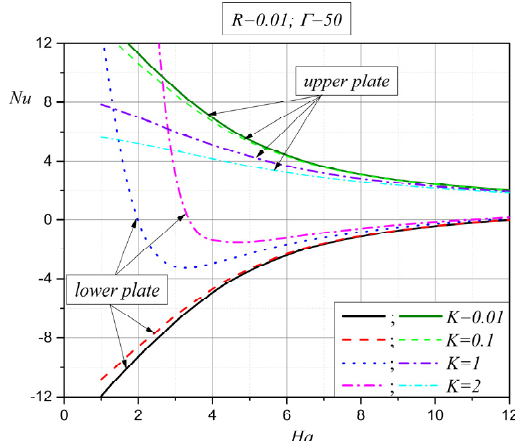
Figure 11. Nusselt number at upper and lower plates as a function of Hartmann number and coupling parameter K .